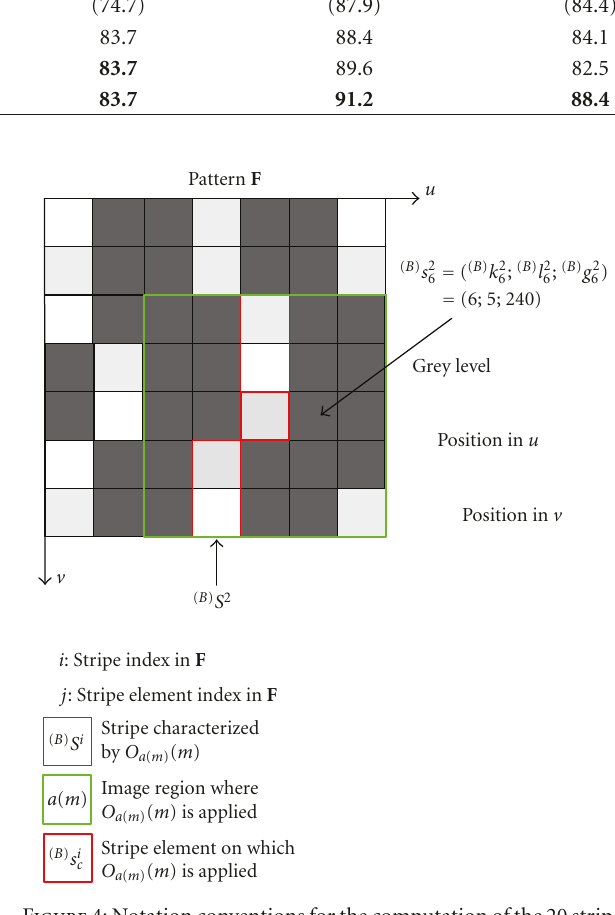
Figure 4: Notation conventions for the computation of the 20 stripe